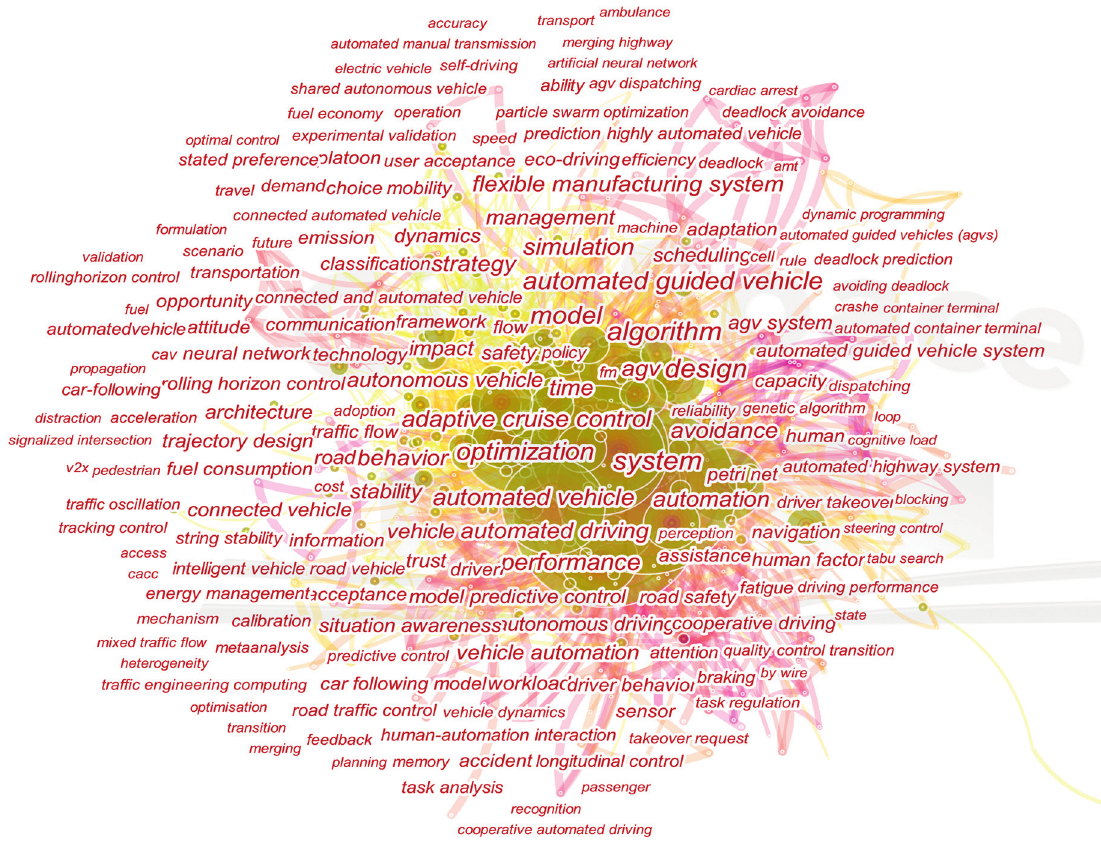
Figure 8: Keyword co-occurrence network. Table 6: Frequency of keywords for autonomous driving